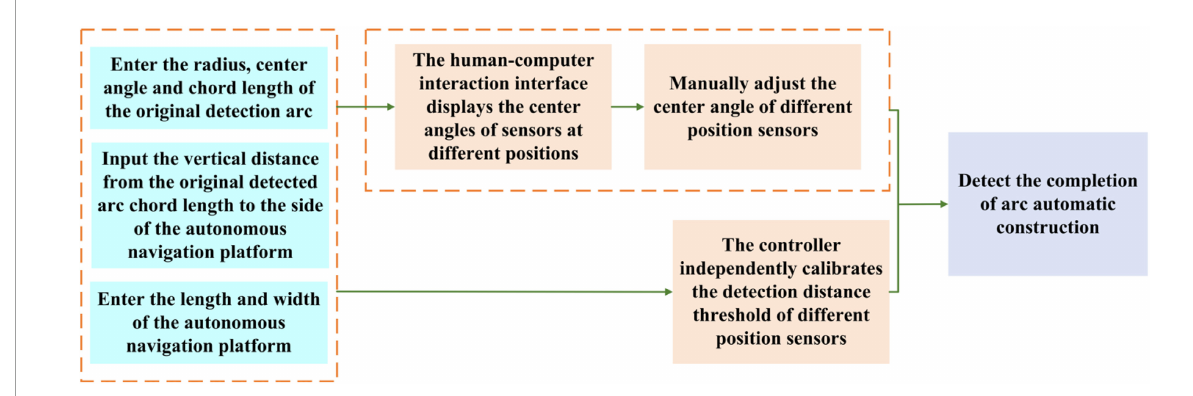
FIGURE15 A schematic diagram of the construction method for detecting arc-adaptive calibration.